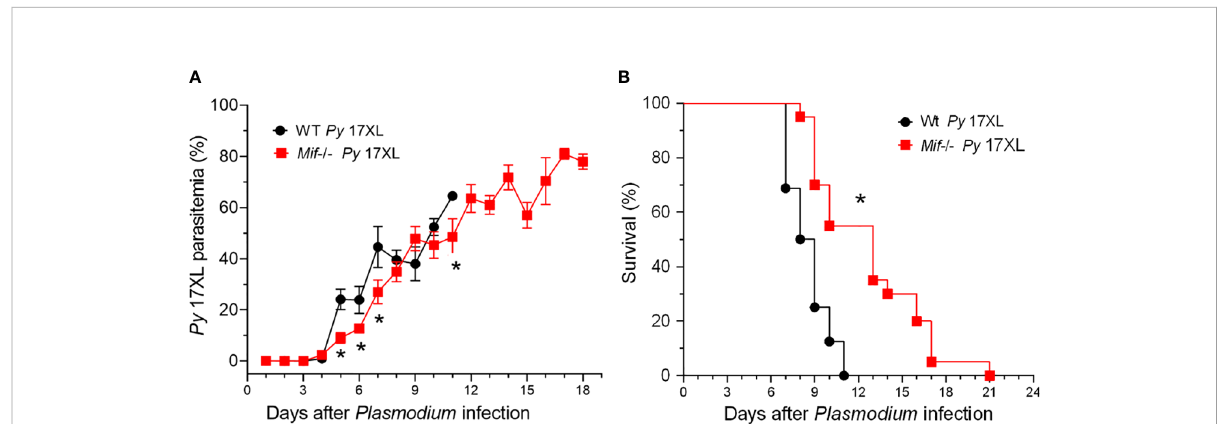
FIGURE 2 MIF de fi ciency delays the host mortality induced by Plasmodium yoelii 17XL infection. Wild-type and Mif -/- mice were intravenously infected with 1×10 3 Py 17XL-parasitized erythrocytes. (A) Parasitemia is expressed as the mean % of Py -parasitized erythrocytes in each group. (B) Survival rate for each experimental group. Data are expressed as the mean ± SEM and are representative of 3 independent experiments with 3 to 5 mice per group. Values of *p < 0.05 were considered statistically signi fi cant relative to the Py 17XL-infected Wt